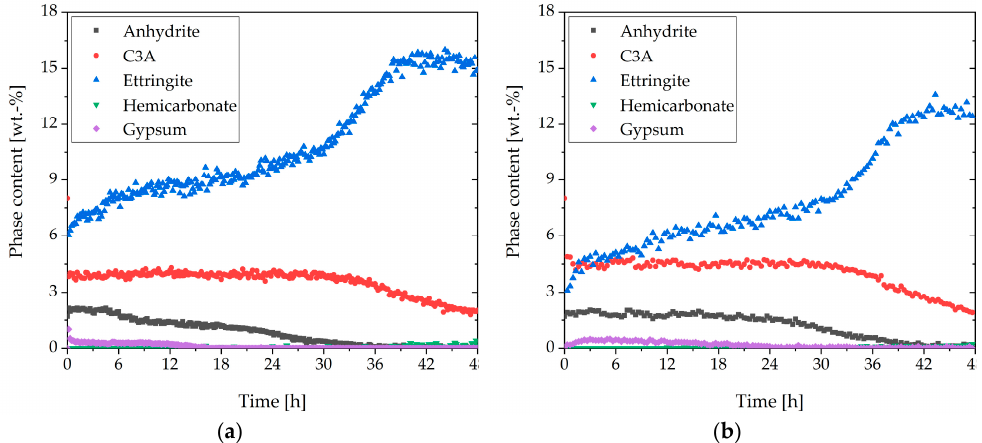
Figure 8. Phase development of the aluminum-containing phases of CEM I during 48 h of hydration (w/c = 0.36) with: ( a ) 2 wt% of gypsum and 0.7 wt% of SP (direct addition), and ( b ) 0.7 wt% of SP (delayed addition).